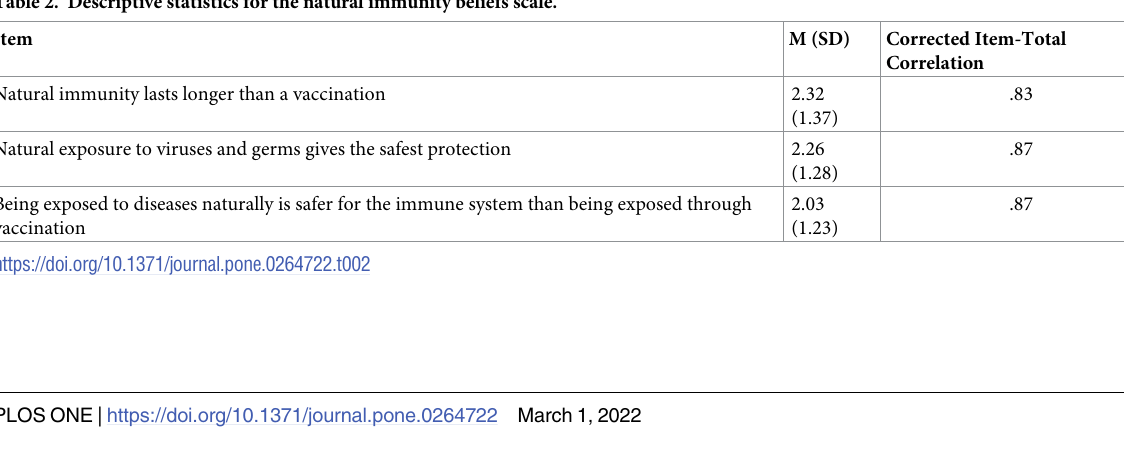
A three-item scale of natural immunity beliefs was taken from the Martin and Petrie [41], Vaccination Attitudes Examination (VAX) scale. Those items were answered on a five-point scale ranging from 1 = completely disagree to 5 = completely agree, as well. These three items were also summed in order to get the total summary score (M = 6.60, SD = 3.63; M = 6.92; SH SD = 3.83; M = 6.23; SD = 3.34; t = 2.32; p = 0.02) since the internal consistency, as SH STEM STEM measured by Cronbach’s alpha, was high (0.93). Higher values represent higher belief in natu- ral immunity. The descriptive statistics for the items are shown in Table 2. The trust in healthcare system was measured by using a revised version of the nine-item scale constructed by Shea et al. [42], To be more specific, we left out the item about the equal treatment of patients of all races and ethnicities given that the Croatian society is largely mono-ethnic and mono-racial. All the items were answered on a five-point scale ranging from 1 = completely disagree to 5 = completely agree. Even though Shea et al. [42] confirmed that the scale can be divided into two sub-scales (value congruence and competence), in the current study this scale proved to be one-dimensional with a high level of reliability (Cronbach’s alpha was equal to 0.90). The descriptive statistics for the items is shown in Table 3, whereas the total summary score was also used in subsequent analyses (M = 23.82, SD = 6.37; M = 23.28; SH SD = 6.34; M = 24.46; SD = 6.35; t = -2.22; p = 0.03) with higher values represent- SH STEM STEM ing higher trust in healthcare system.